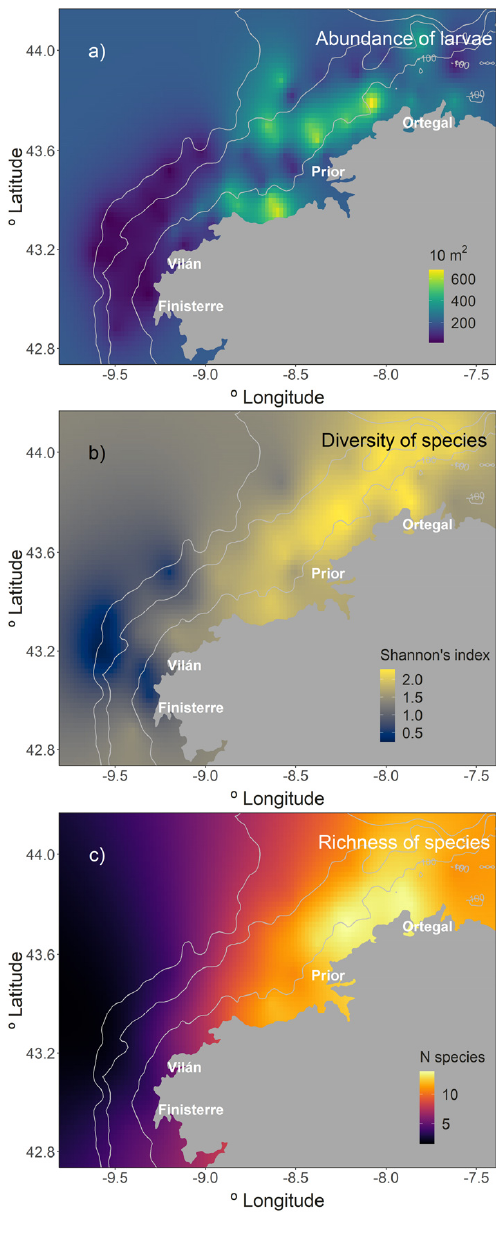
Figure 4. Distribution of the LFC parameters of ( a ) abundance, ( b ) diversity, and ( c ) richness. The maximum abundance (749.6 larvae · 10 m − 2 ) of larvae was recorded on the Artabro coast and it was mainly due to the contribution of the family Gobiidae (161.8 larvae · 10 m − 2 ) and non-identified larvae (275 larvae · 10 m − 2 ). The second highest value of abundance (668.3 larvae · 10 m − 2 ) was found south of Artabro Gulf, where T. trachurus contributed the most to the total larvae abundance (244 larvae · 10 m − 2 ) (Figure 4a). Regarding diversity of the community, the highest value was recorded between Cape Prior and Cape Ortegal and for richness the maximum was registered near the Artabro coast (Figure 4b,c). The species richness values ranged from 0 to 20 (11.9 ± 4.7), and the Shannon index ranged from 0 to 2.7 (1.9 ±